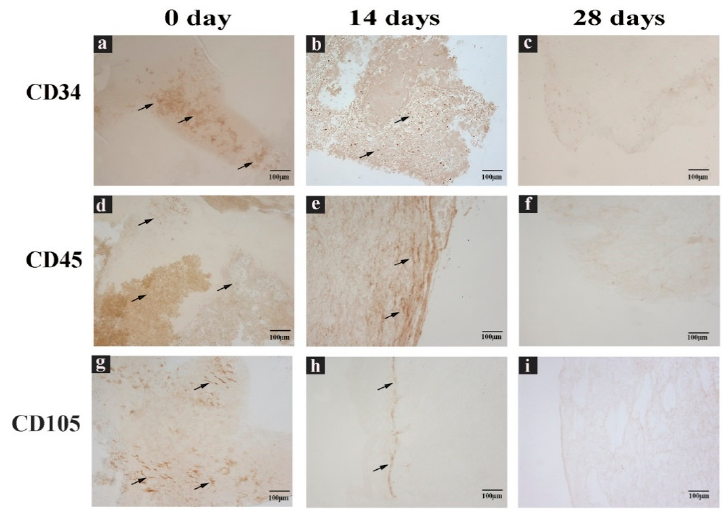
Figure 4. CGF sections labeled with immunohistochemical assay. ( a , d , g ) Sections of CGF at 0 days, ( b , e , h ) 14 days, and ( c , f , i ) 28 days of incubation in culture medium. Incubated with ( a – c ) anti CD34 antibody, ( d – f ) anti CD45 antibody, or ( g – i ) anti CD105 antibody. Black arrows indicate the positive immunolabel. Scale Bar: 100 µ m.